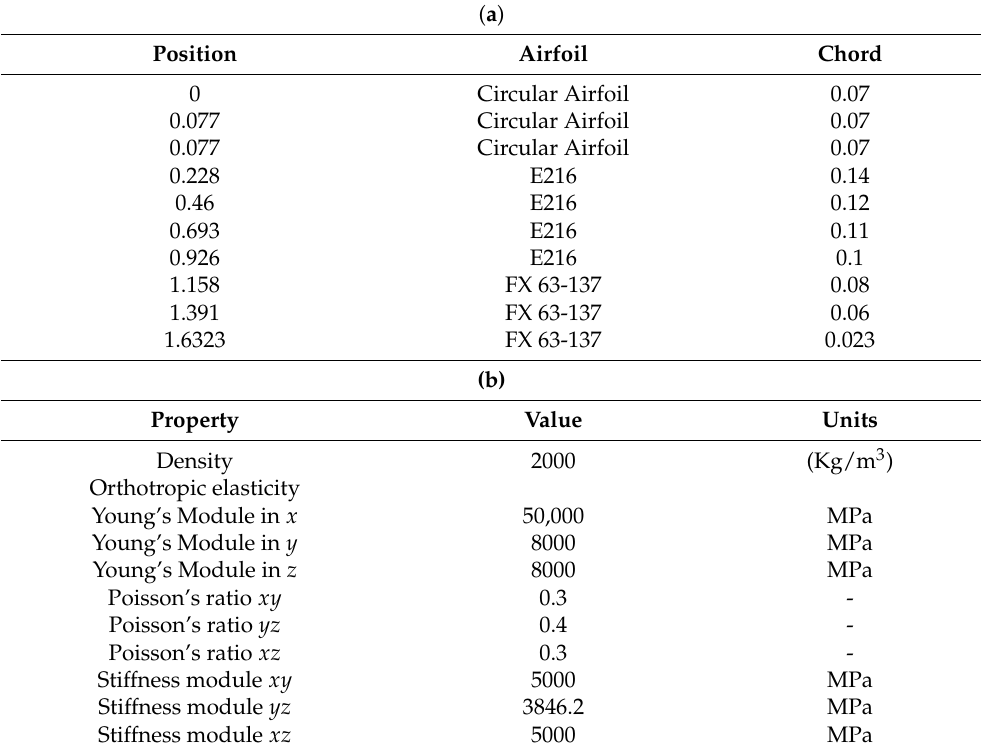
Table 2. ( a ) Wind turbine blade design. ( b ) Blades properties.